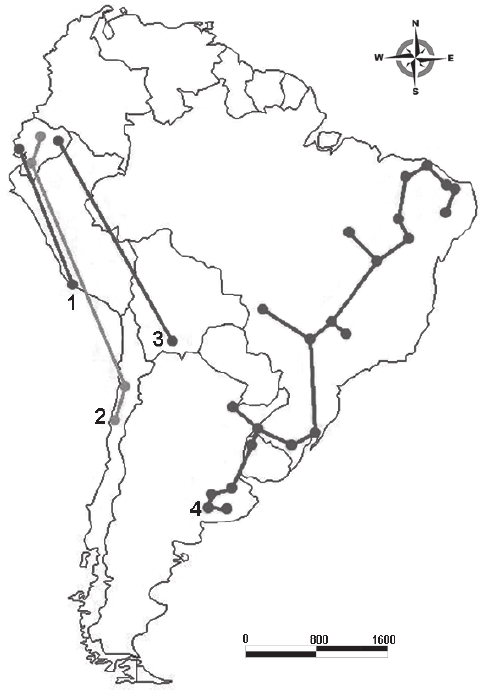
Fig. 2 - Individual tracks of Equus (1 - Equus andium ; 2 - E. insulatus ; 3 - E. neogeus ; 4 - E. santaelenae ).